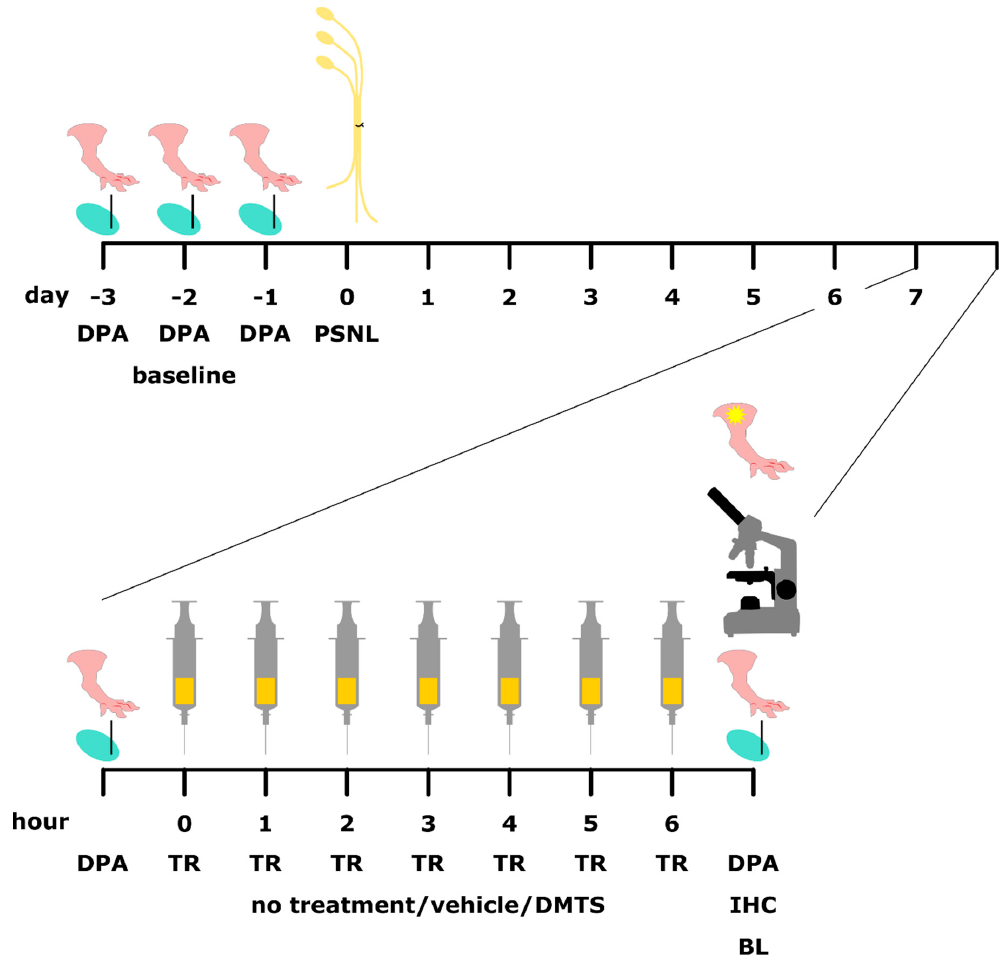
Figure 8. Schematic of the experimental design. DPA: dynamic plantar esthesiometry to detect mechanical pain threshold of hind paws; PSNL: partial sciatic nerve ligation; TR: treatment; IHC: immunohistochemistry of IBA1 in the spinal cord dorsal horn; BL: bioluminescent detection of macrophages at the lesion site.